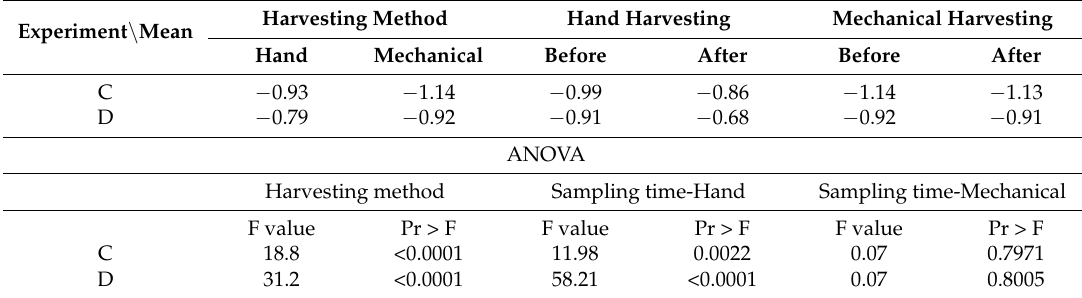
Table 3. Means and analysis of variance for the harvesting methods effect on stem water potential (MPa) at Felda site in the southwest of Florida during 2016 seasons.